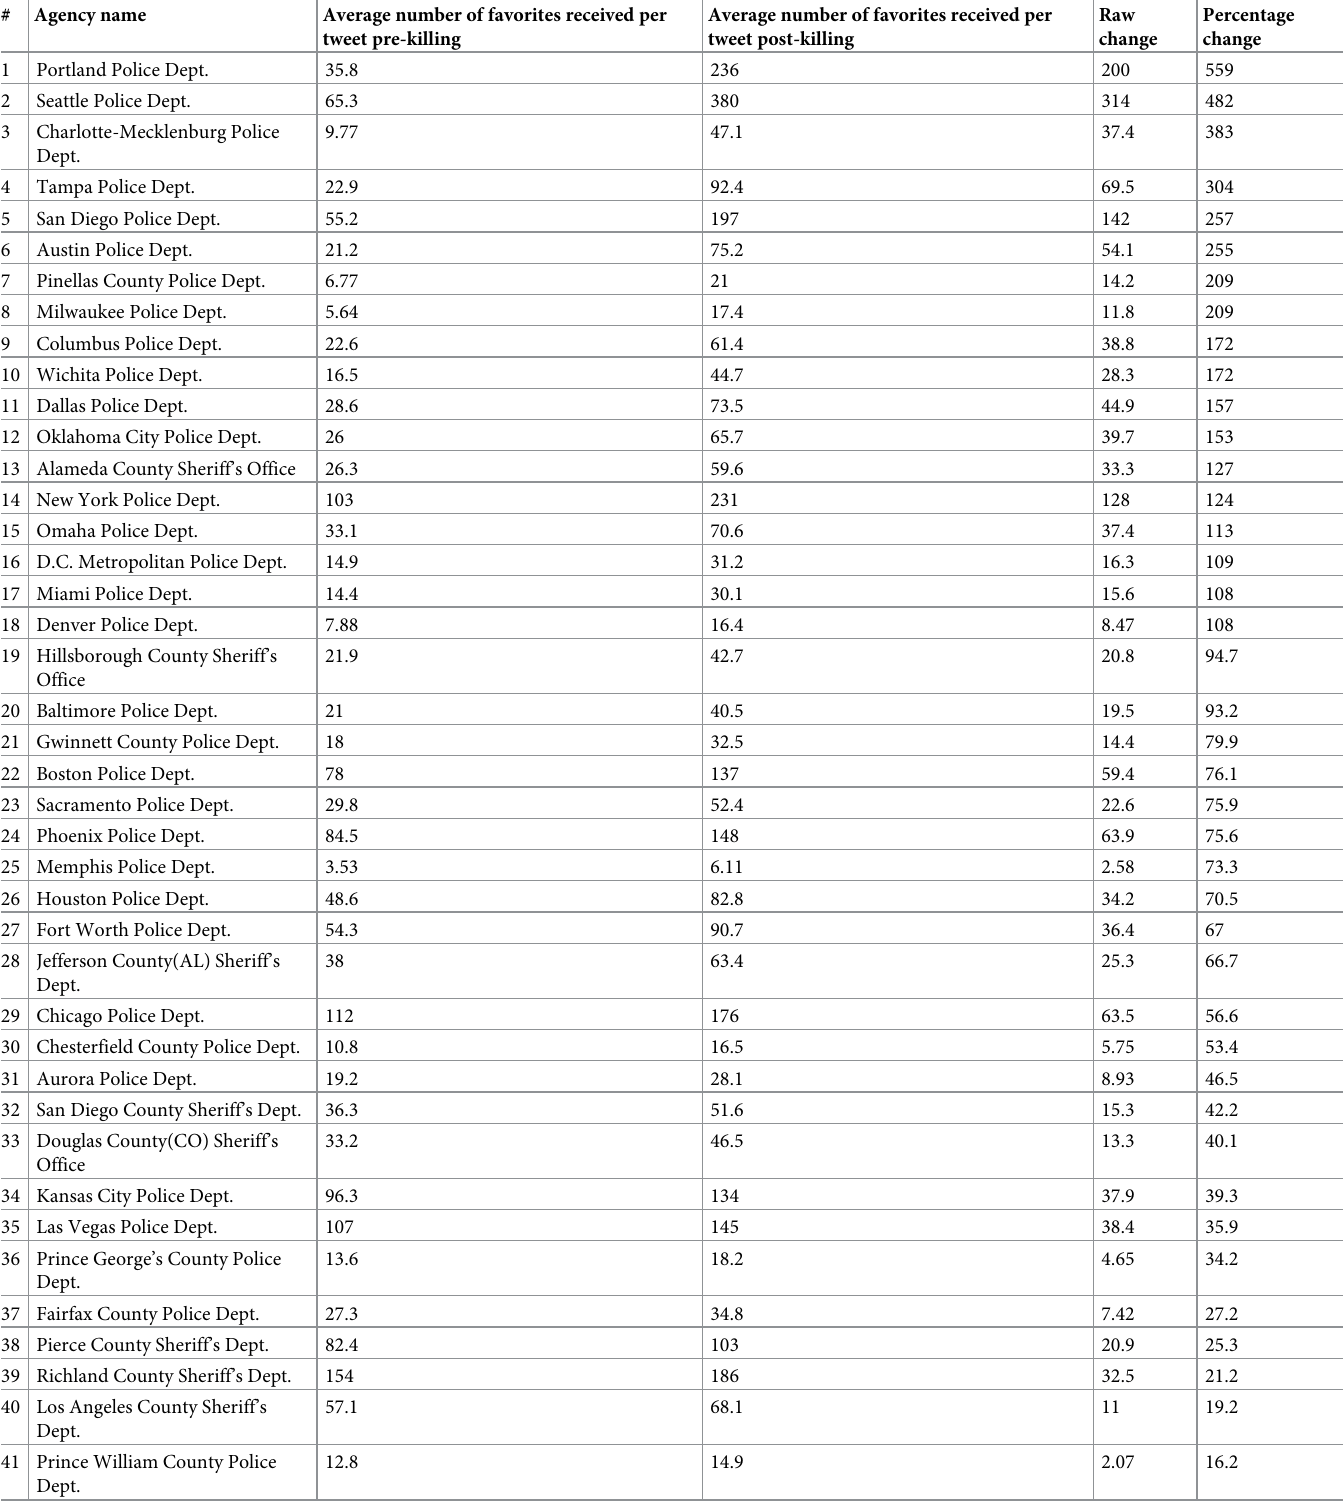
Table 5. Agencies (in the higher-use group) ranked by the increase in the received favorites per tweet before and after the